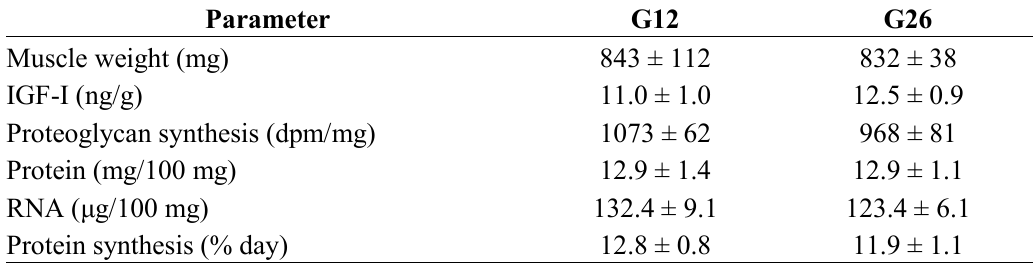
Table 4. Growth and protein synthesis in gastrocnemius muscle tissue 1,2 .